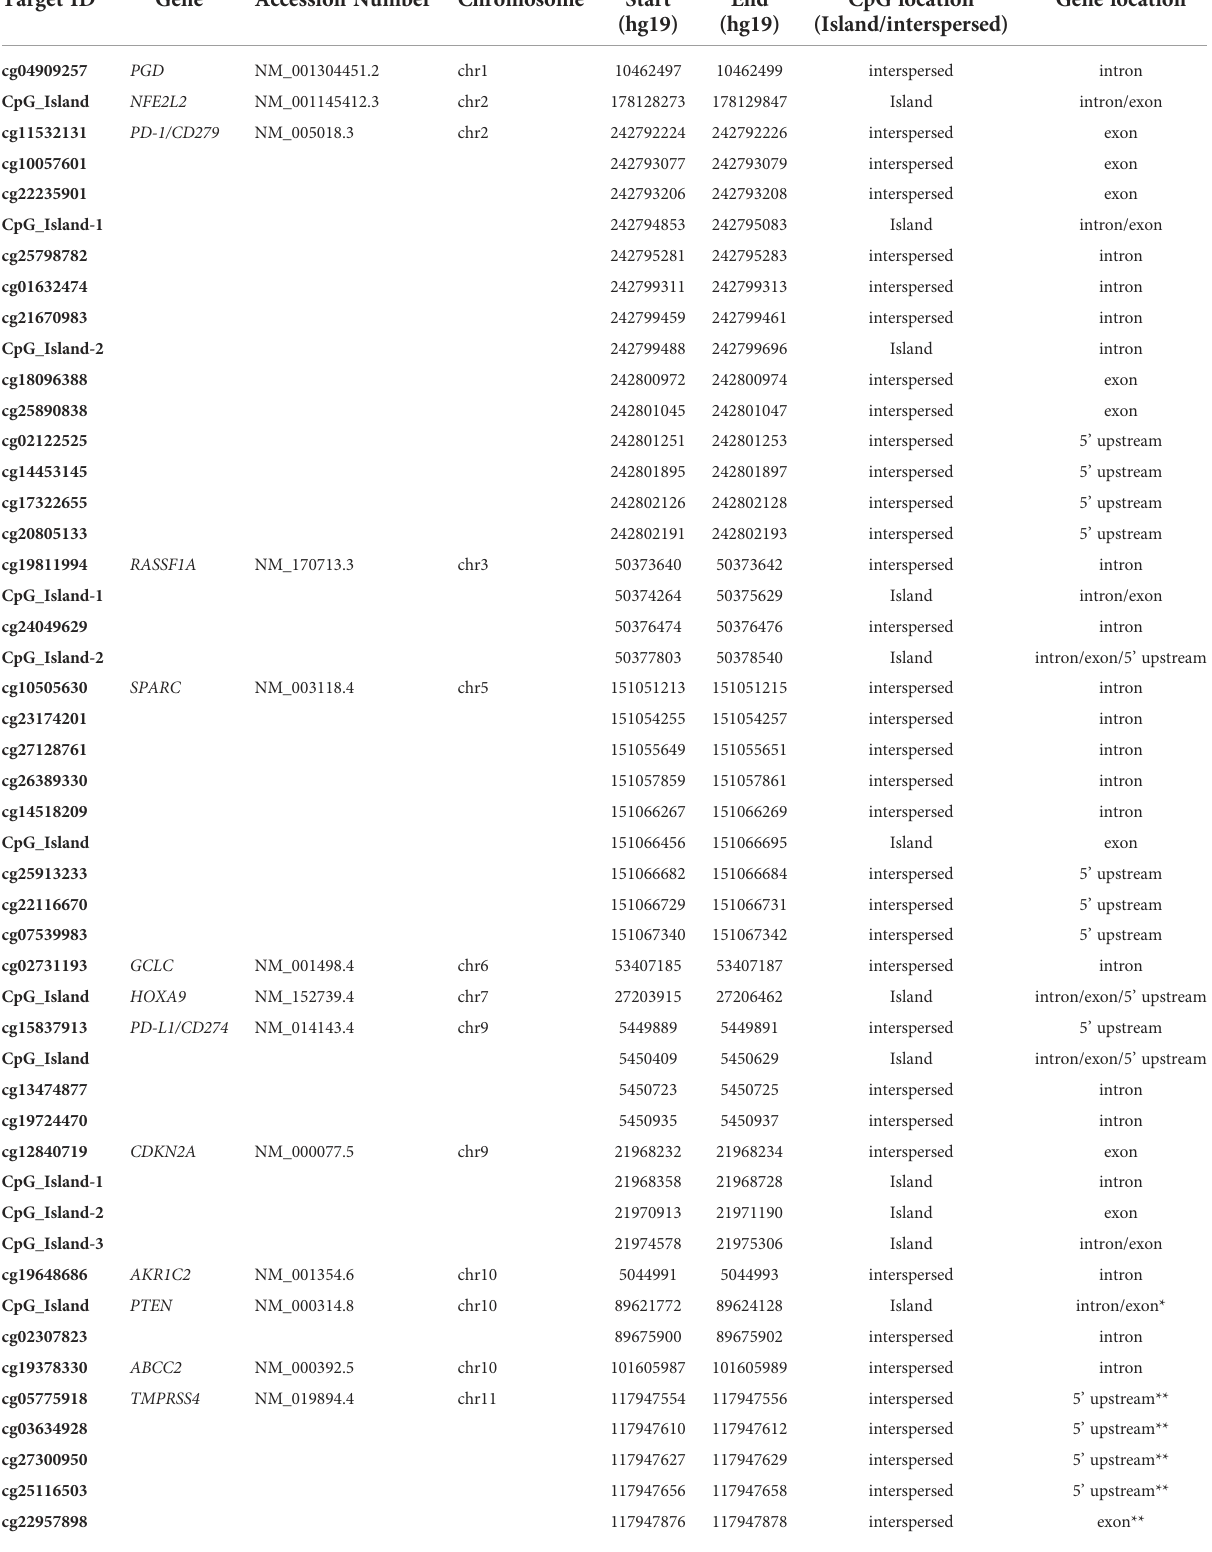
TABLE 1 Full list of targeted CpGs by OPERA_MET-A